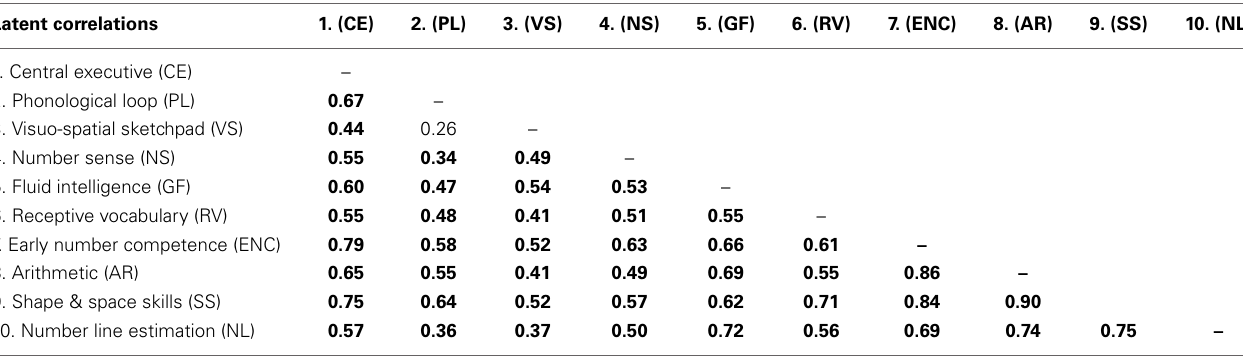
Table 2 | Latent correlations between factors Latent